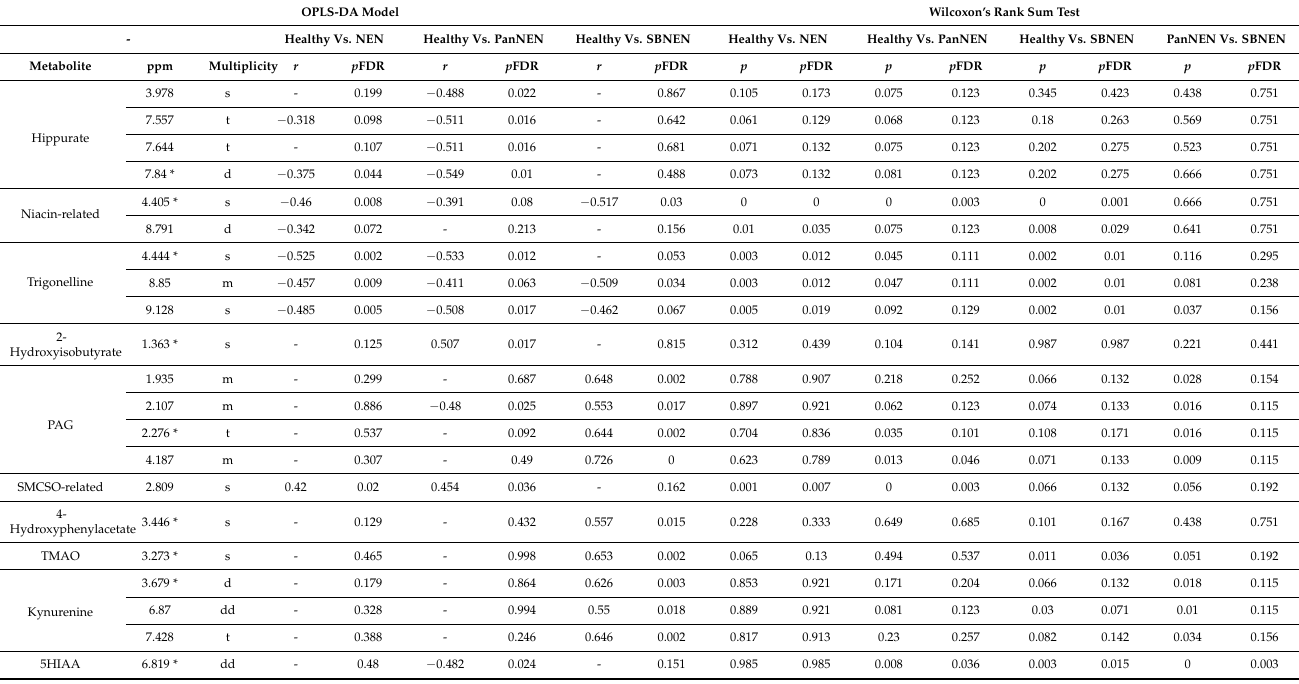
Table 2. Correlation coefficients and p -values of chemical shifts from OPLS models and Wilcoxon’s rank sum